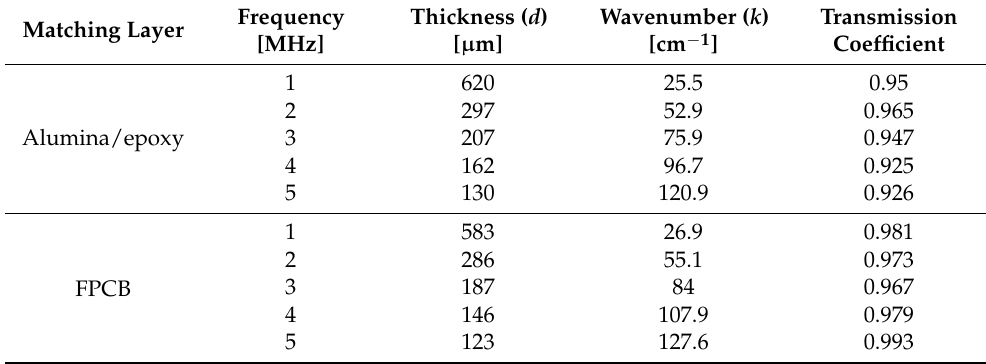
Figure 2. Acoustic properties of the alumina/epoxy matching layer and FPCB matching layer: ( a ) Speed of sound, ( b ) acoustic impedance, and ( c ) transmission coefficient of the ultrasound through the matching layer at different frequencies ( n = 4). Table 1. Summary of the calculated thickness ( d ) and the corresponding wavenumber ( k ) used to estimate transmission coefficients of the alumina/epoxy and FPCB matching layers.